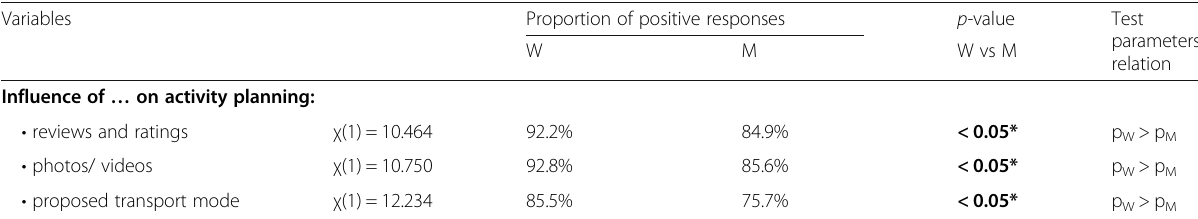
Table 5 Summary of test results for comparisons between women and men regarding influence of social media on activity planning Variables Proportion of positive responses